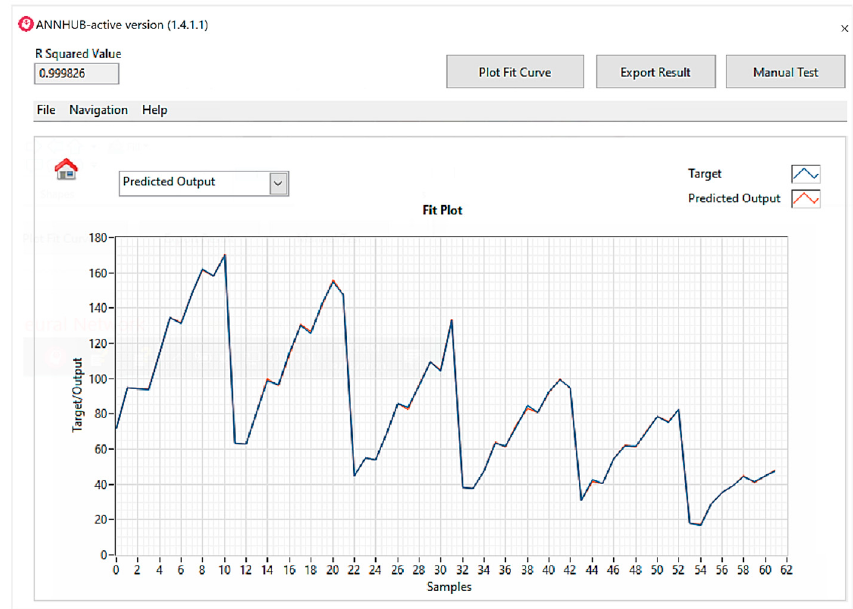
Figure A4. Visual assessment of the Levenberg–Marquardt ANN performance—predicted Pe outputs (red) vs. test outputs